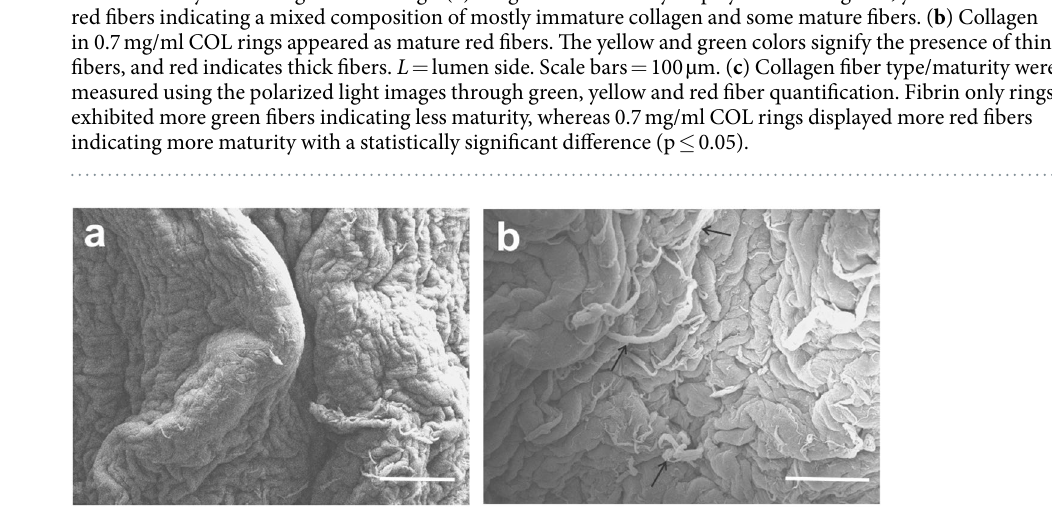
Figure 7. Scanning electron microscopy shows cell sheet continuity. ( a ) Cell sheet in the ring. ( b ) Collagen fibrils present within the cell sheet. Scale bars = 200 µ